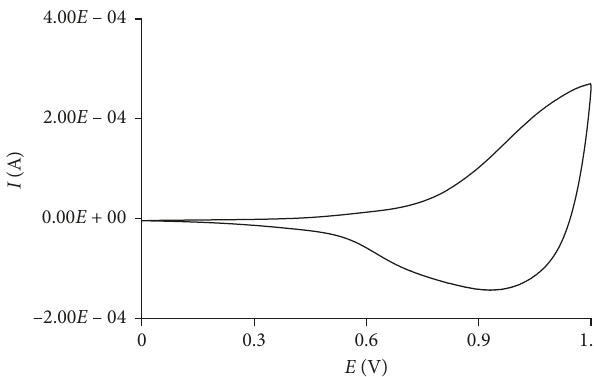
Figure 1: Cyclic voltammetry characterization of the poly(2,2